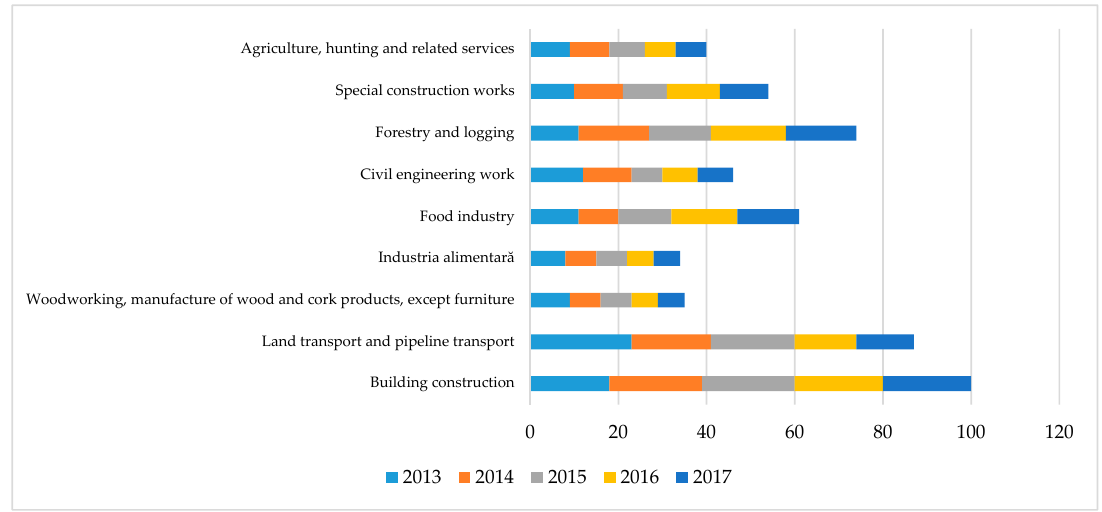
Figure 13. Number of fatal accidents in Romania during 2013–2017 [1,2].